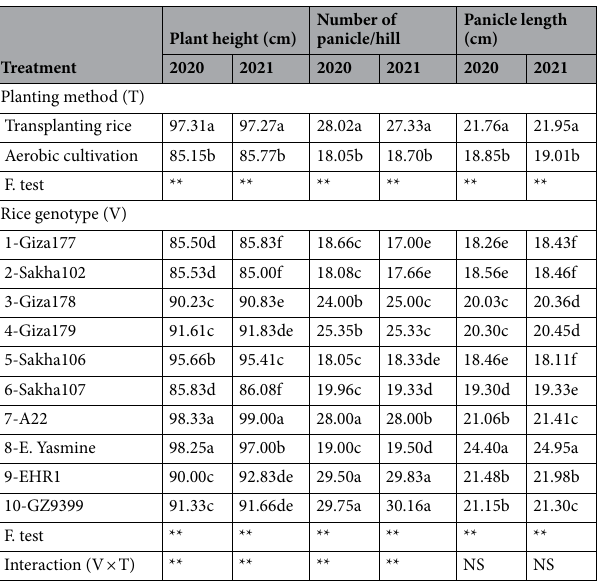
Table 11. Some yield attributes of some rice genotypes affected by the planting methods during the two seasons. **Significant at 0.01 level. Means followed by a common letter at the same column are not significantly different according to Duncan ’ s multiple range at 0.05 levels.